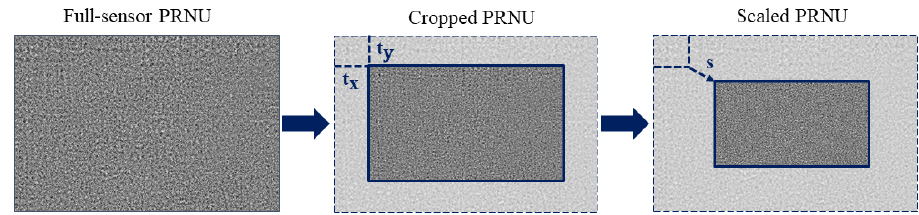
Figure 2. In-camera processing involved in video